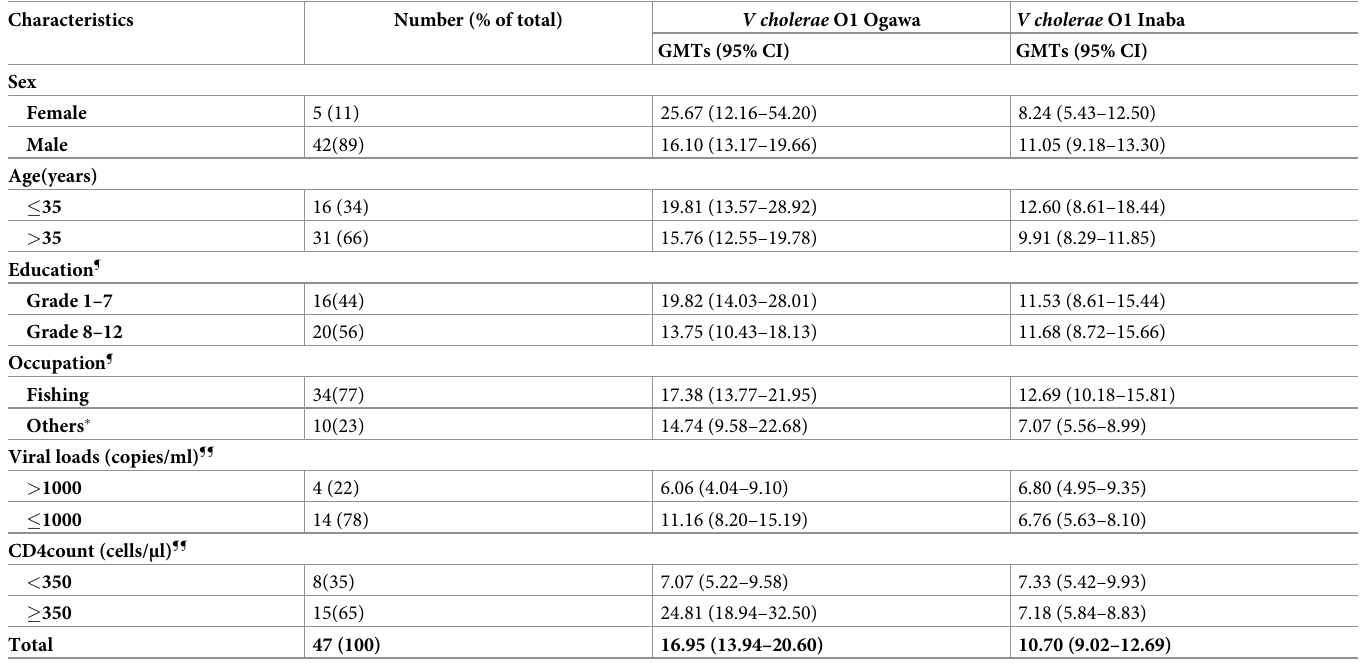
Table 1. Geometric mean ratios of V . cholerae O1 Ogawa and V . cholerae O1 Inaba by background characteristics of participants.